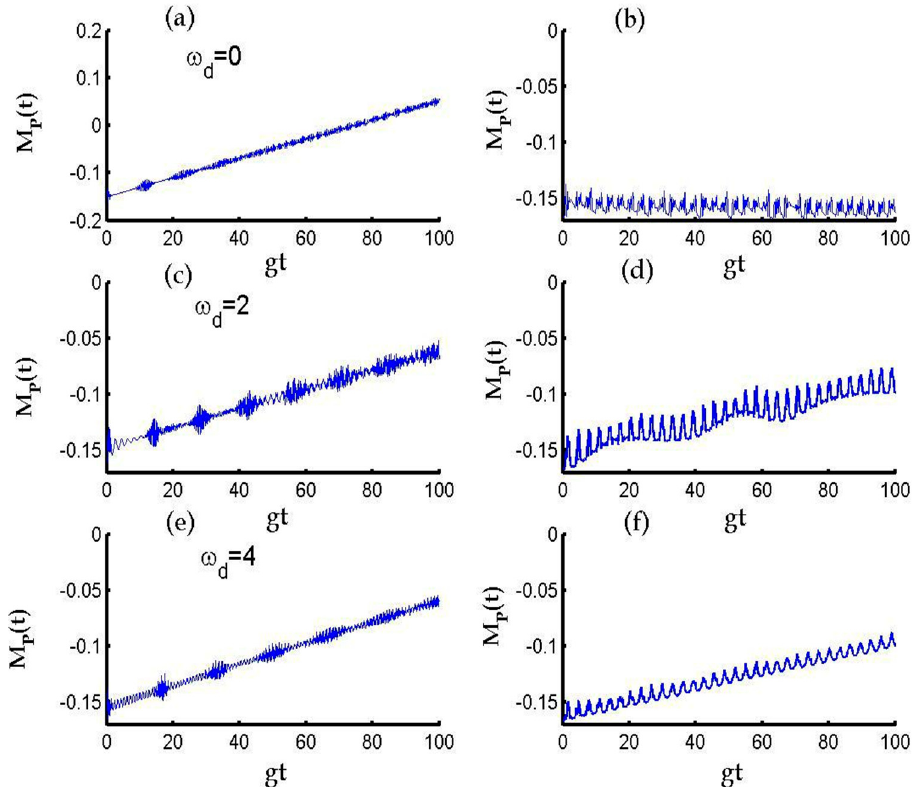
Figure 6. (Color Online) Mandel’s parameter given in Equation (6) is plotted vs. the dimensionless time gt for various values of the energy detuning for one-photon transition ( l = 1) with | α | 2 = 10. ( a , c , e ) present the variation of the quantumness in the field in the absence of the time-dependent effect G ( t ) = g ; ( b , d , f ) exhibit the variation of the quantumness in the field in the presence of the time-dependent effect G ( t ) = g sin 2 ( t ) . ( a , b ) is for ω d = 0; ( c , d ) is for ω d = 2; and ( e , f ) is for ω d =